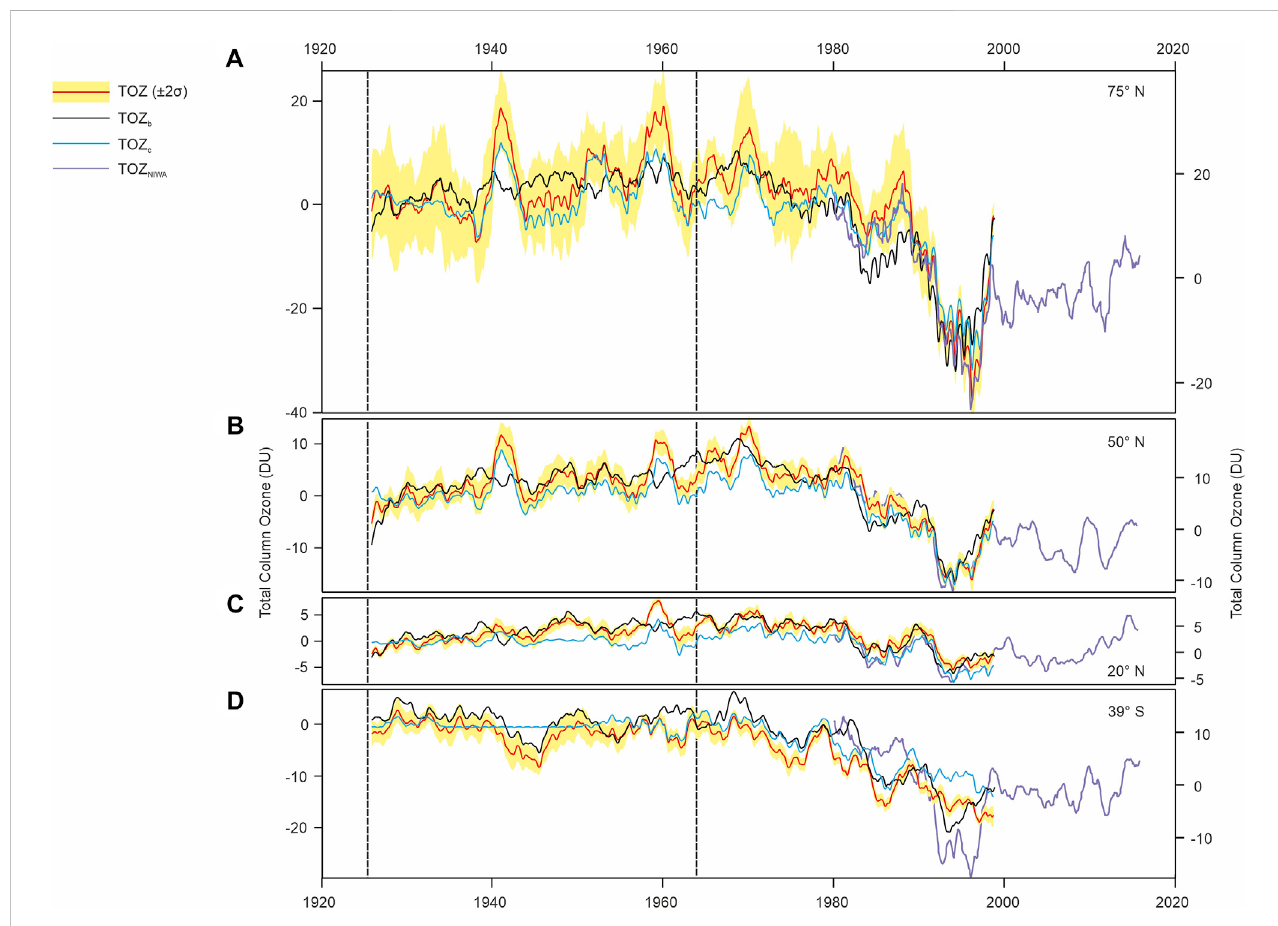
FIGURE 5 Time series ofTOZ(including ±2standard deviations),TOZ c , TOZ b (all onthe leftscales), and TOZ NIWA (right y -axes) atlatitudes of (A) 75 ° N, (B) 50 ° N, (C) 20 ° N, and (D) 39 ° S. The data were deseasonalized (based on the 1924 – 1974 period, in the case of TOZ, TOZ c , and TOZ b ; based on 1979 – 2016, in the case of TOZ NIWA ) and then fi ltered with a 28-month moving